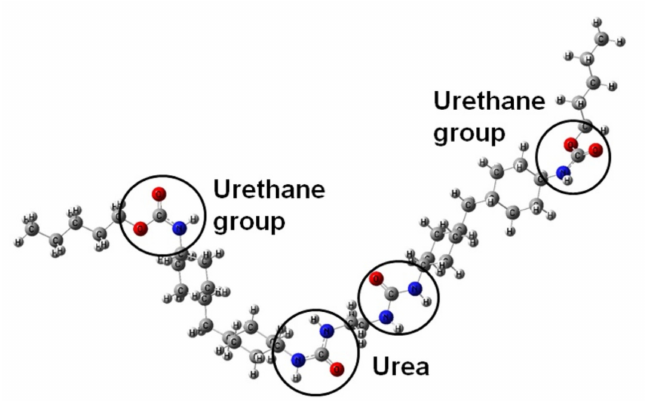
Figure 1. Optimized geometry of WBPU. Grey, red, blue, and white color circles represent carbon, oxygen, nitrogen, and hydrogen atoms, respectively.